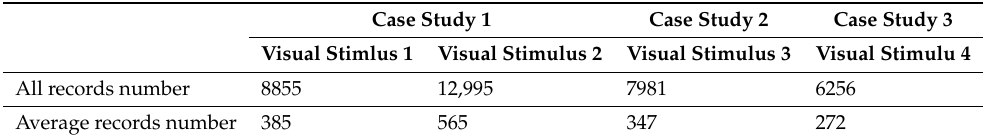
Table 2. Number of eye tracking data records collected from 23